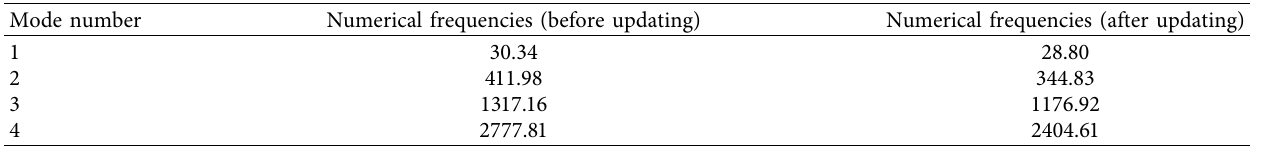
Table 3: Numerical frequencies of the studied beam before and after updating. Mode number Numerical frequencies (before updating) Numerical frequencies (after updating)